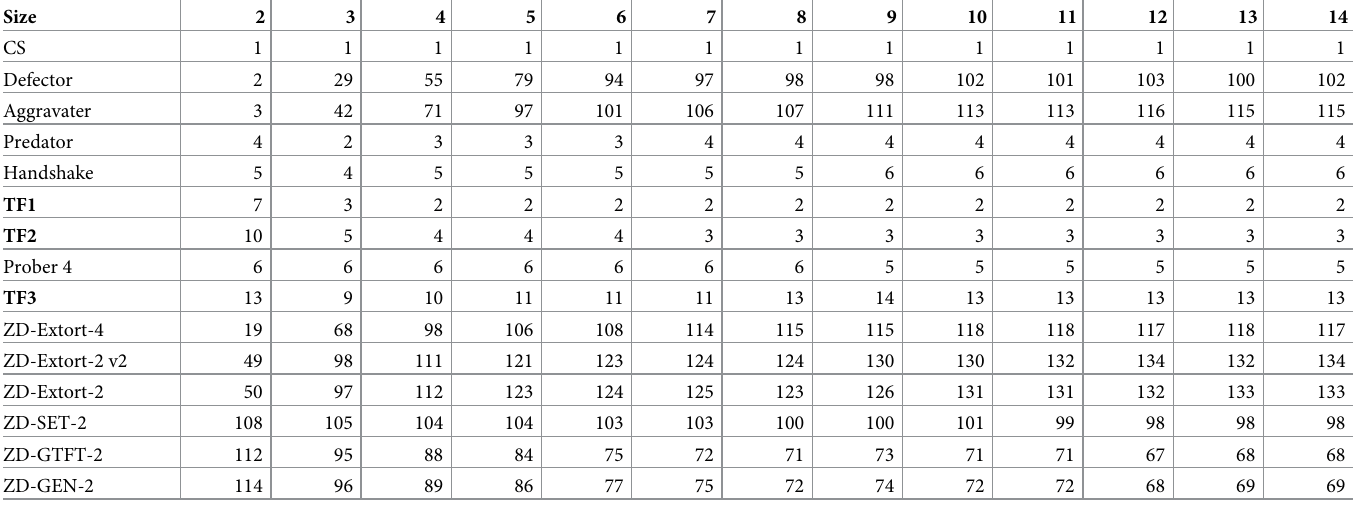
for different population sizes. N − 1